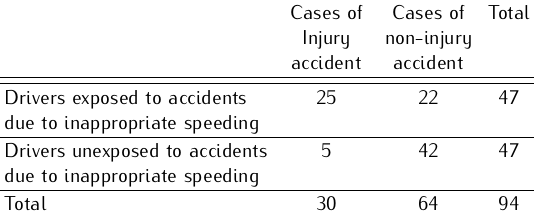
Table 4. Contingency table for inappropriate speeding (year 2005).